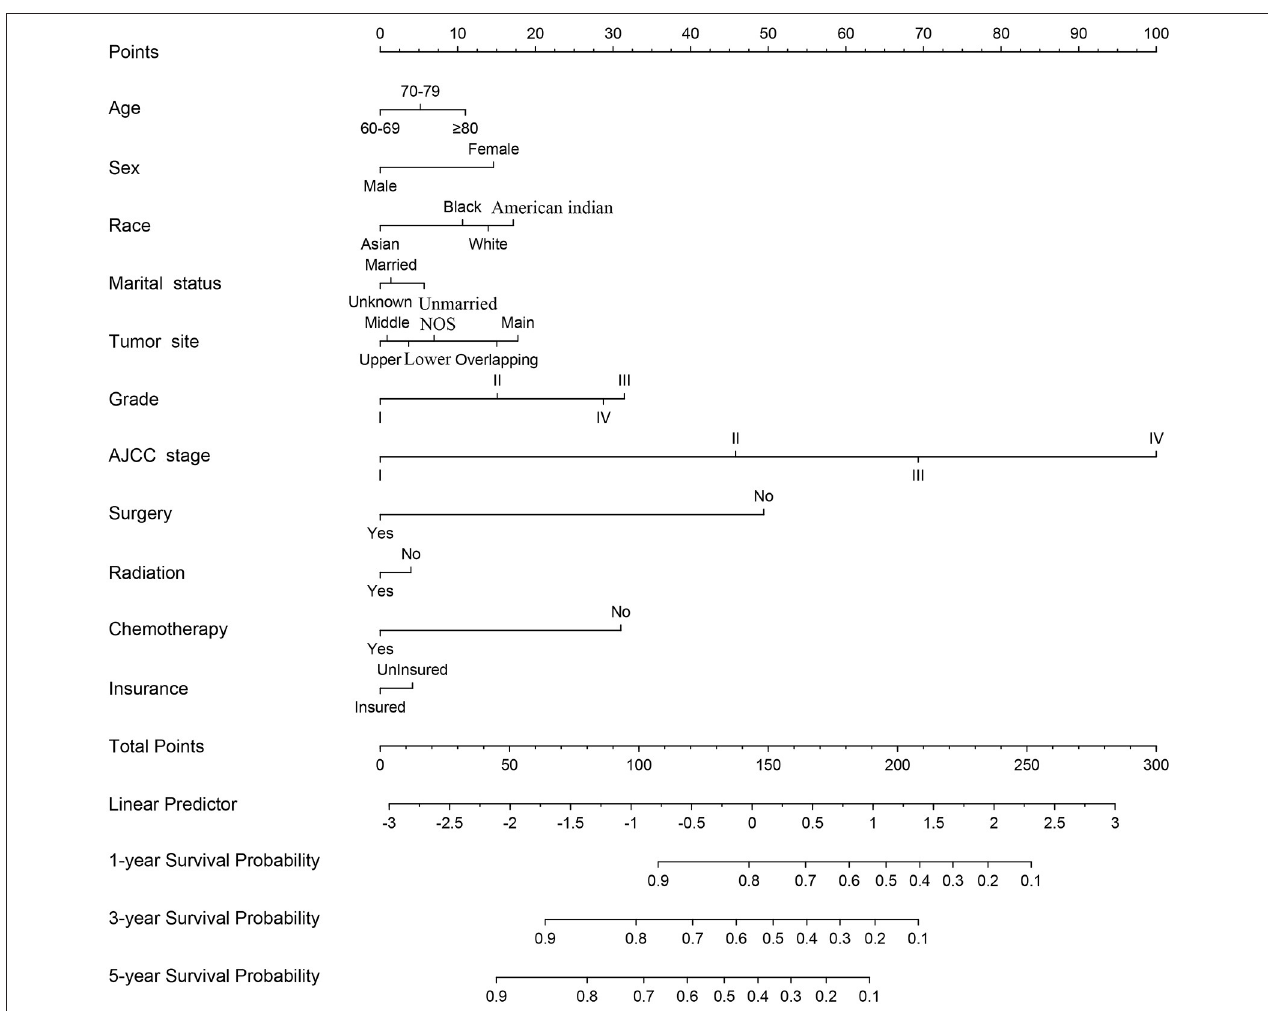
FIGURE 2 | Nomogram predicted 1-, 3-, and 5-year lung adenocarcinoma cancer-specific survival for patients with 11 available factors, including age, sex, race, marital status, tumor site, grade, AJCC stage, surgery, radiation, chemotherapy, and insurance. AJCC, the American Joint Committee for Cancer; NOS, not otherwise specified lung